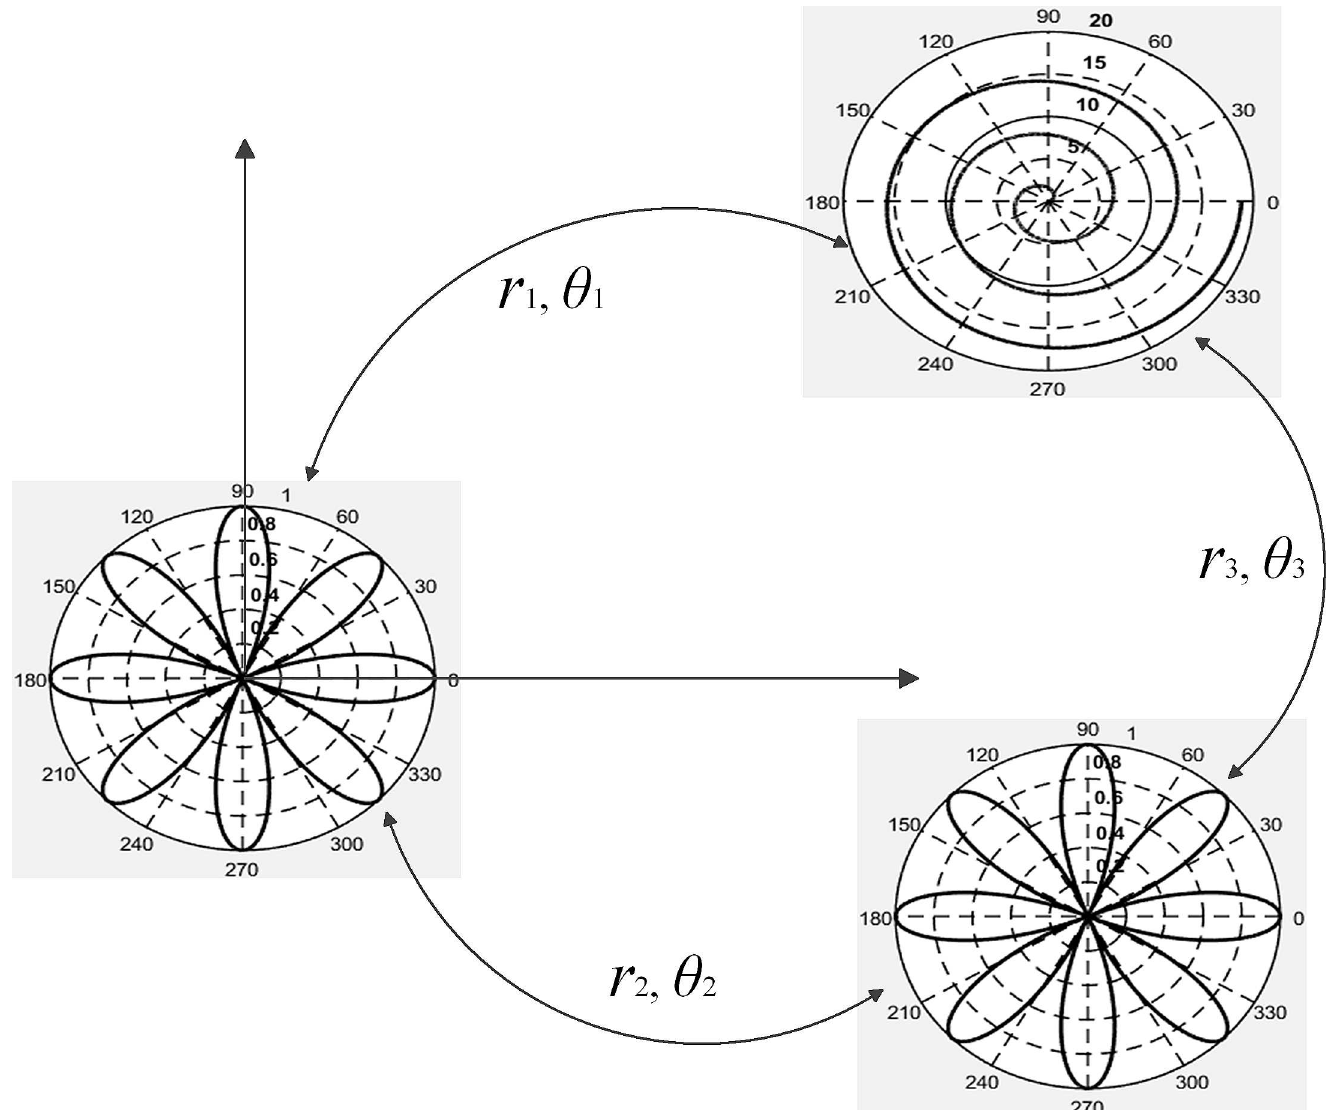
Fig 3. Multi-camera calibration board based on